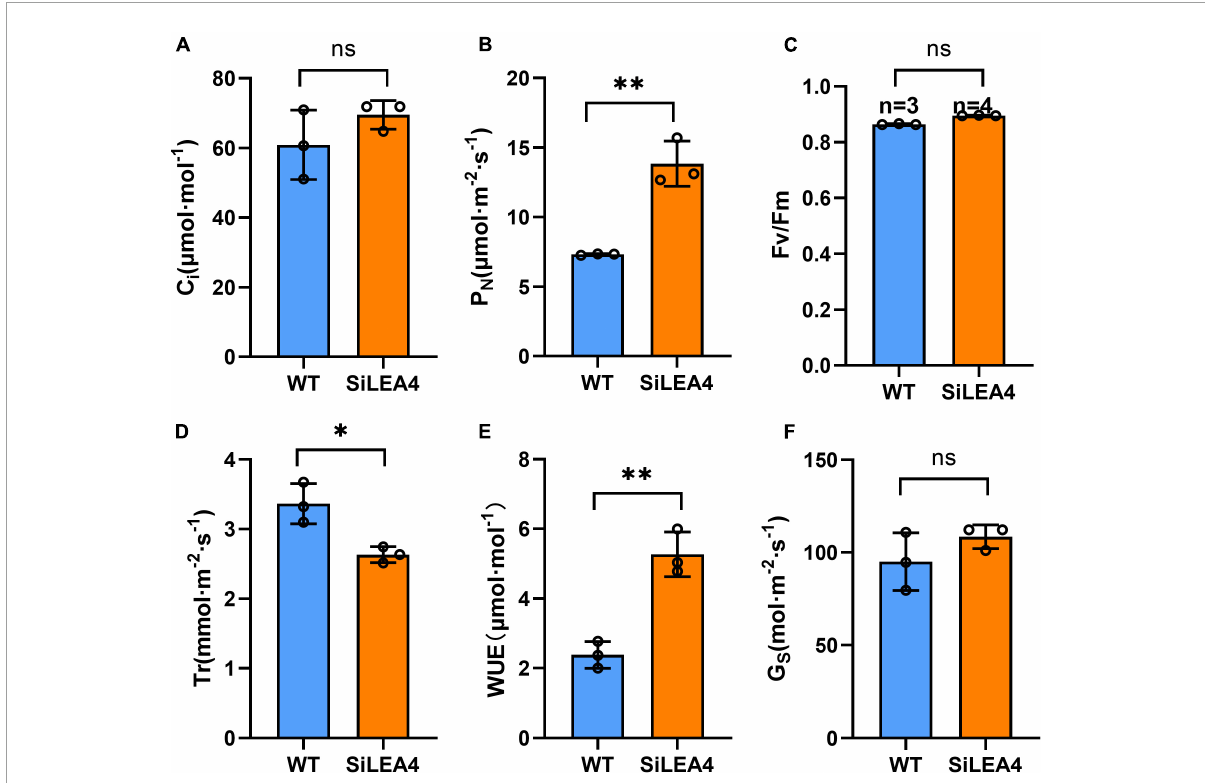
FIGURE8 Photosynthetic capacity analysis of wild-type tomato and transgenic tomato. (A) Intercellular CO 2 concentration; (B) net photosynthetic rate; (C) Fv/Fm values; (D) transpiration rate; (E) water use efficiency; (F) stomatal conductance. Error bars, mean ± SD. n = Number of plants. ns. no significant difference. The asterisks indicate a statistically significant difference (two-tailed Student’s t -test, ∗∗ P <